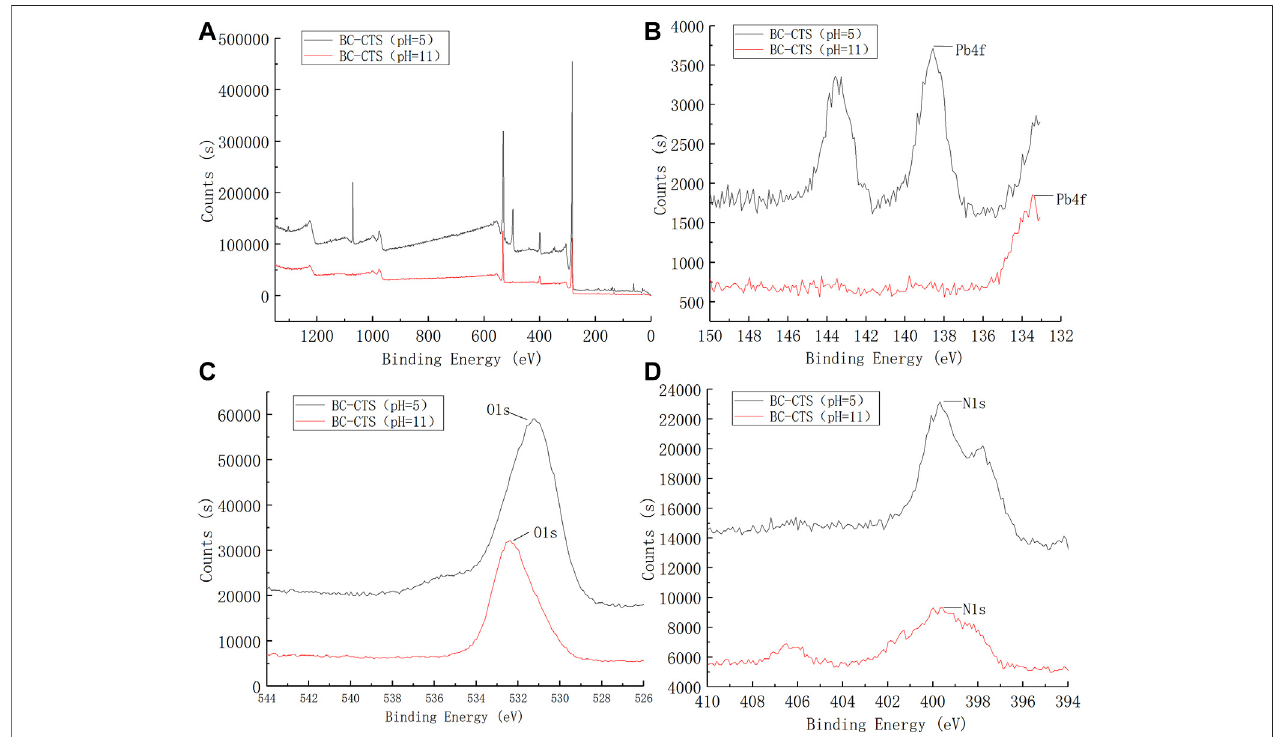
FIGURE 13 | XPS spectrum of BC-CTS. (A) :XPS wide scan of the BC-CTS, (B) Pb4f of BC-CTS, (C) O1s of BC-CTS, (D) N1s of BC-CTS.